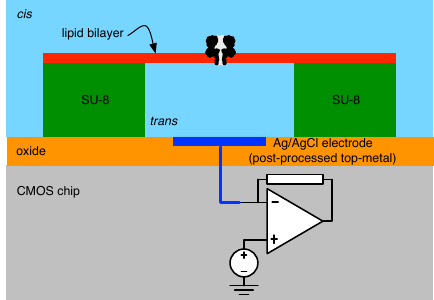
Figure 13. The cross-section of a biological nanopore-to-CMOS interface following the structure reported in [62].